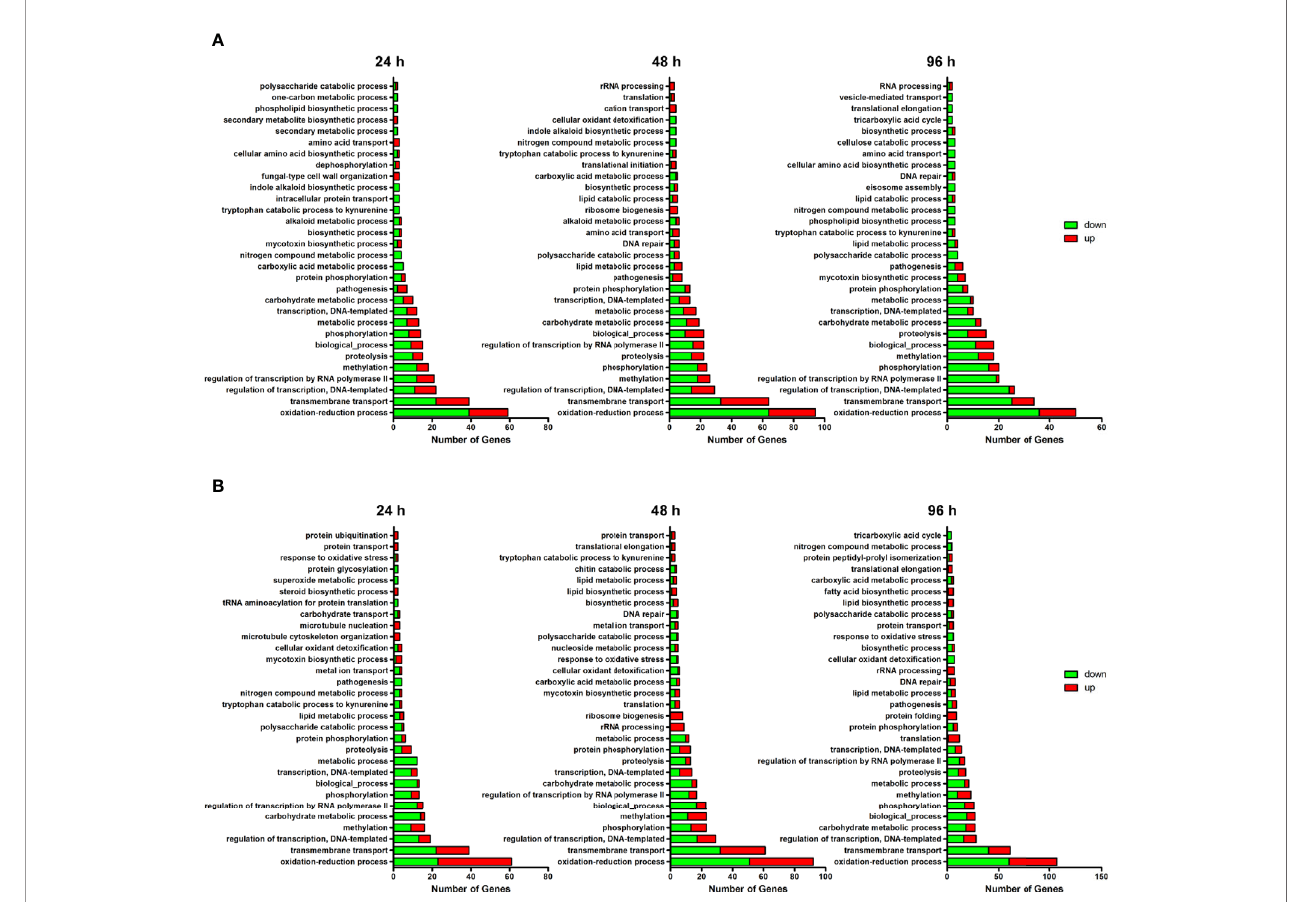
FIGURE 2 | A summary of the Gene Ontology (GO) terms related to biological processes (BP) classi fi cation. Redand green barsrepresent up-and down-regulated genes, respectively. Categories determined for DEGs in D stuAT. rubrum strain during its growth in (A) glucose- and (B) keratin-supplementedmedium at each time